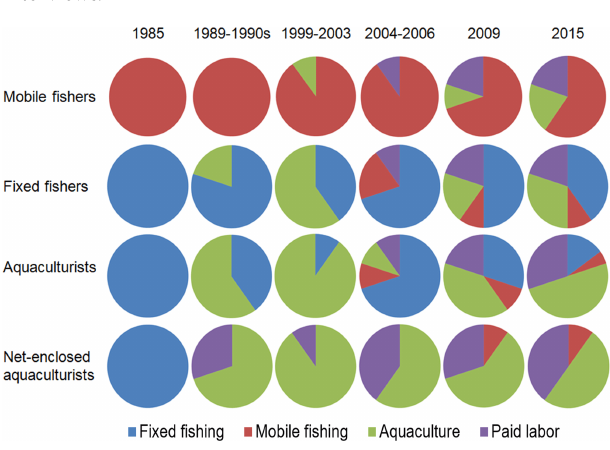
Fig. 4 . Changes in income portfolio from 1985 to 2015 as estimated by different user groups during focus group